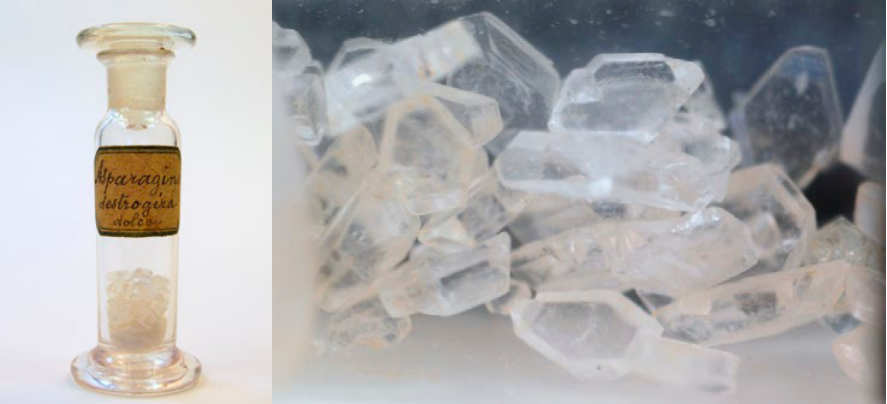
Figure 5. The dextrorotatory sweet asparagine of Piutti: on the left the compound in the original bottle with the original label handwritten by Ugo Schiff; on the right, a particular of the crystals of original asparagines contained in the bottle. This item is conserved in the Schiff Collection of “Ugo Schiff” Chemistry Department at University of Florence (class: Collezione Schiff , DCO20). Courtesy of the Museum of Natural History of the University of